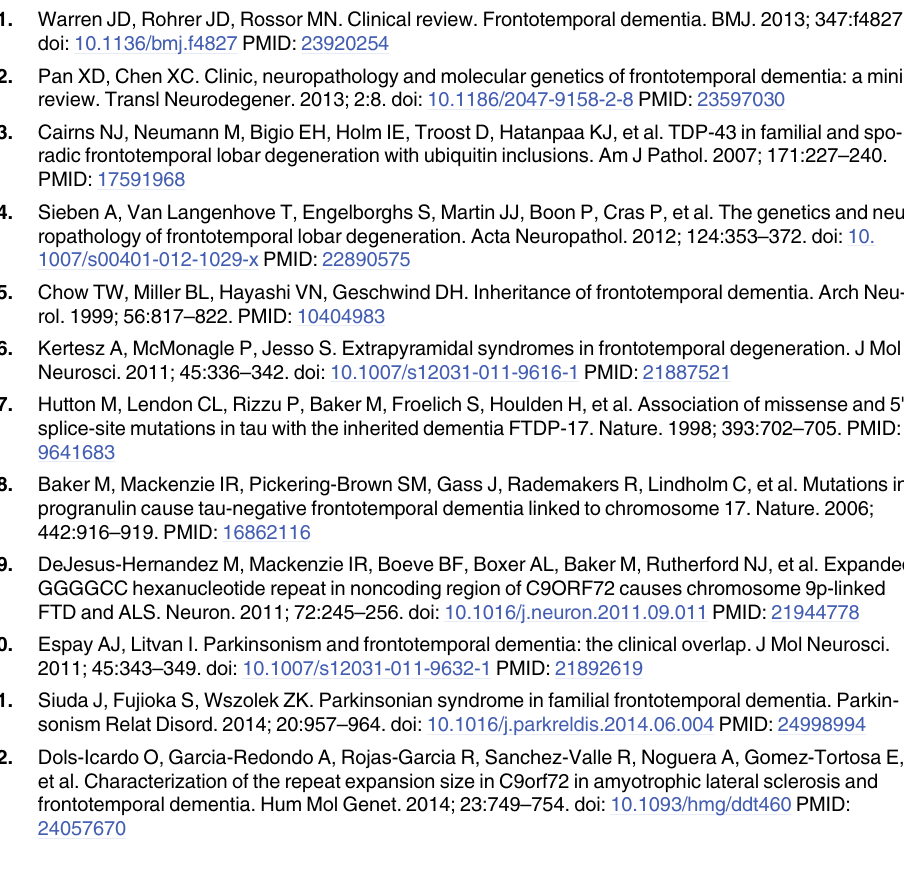
S3 Table. Non-motor presentations. S4 Table. Levodopa responsiveness. S5 Table. Quality of